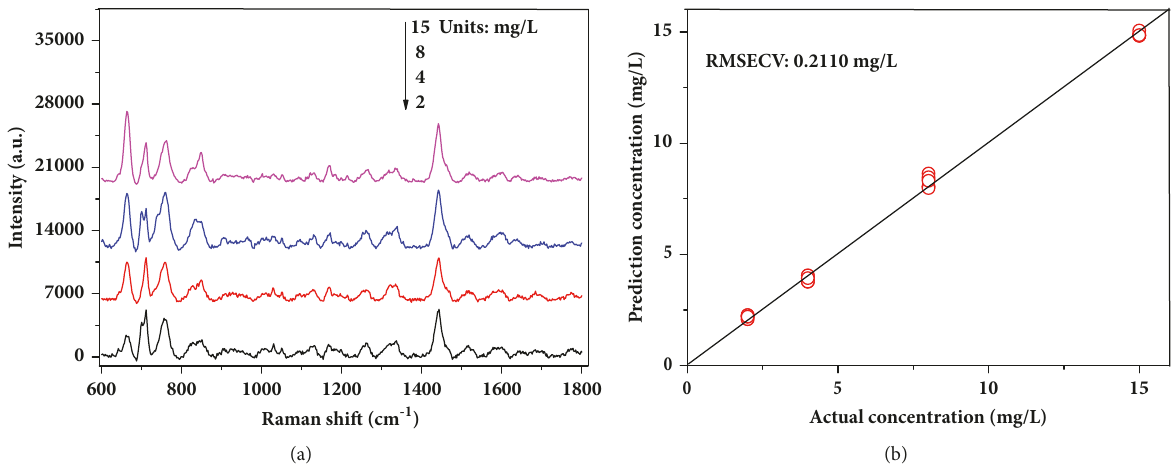
Figure 7: Spectra of 15, 8, 4, and 2 mg/L of chlormequat chloride in wheat extraction solution (a), predicted results by using SVR and KPCA